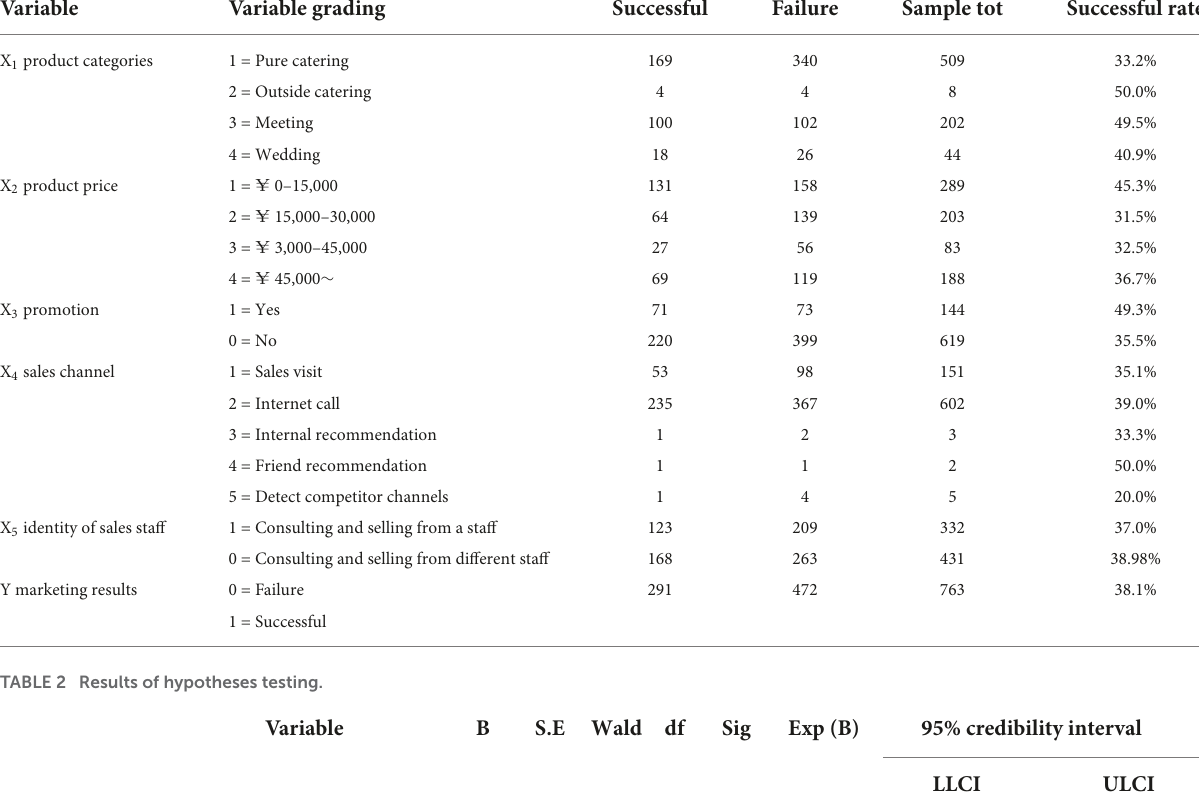
TABLE 1 Classification of variable.